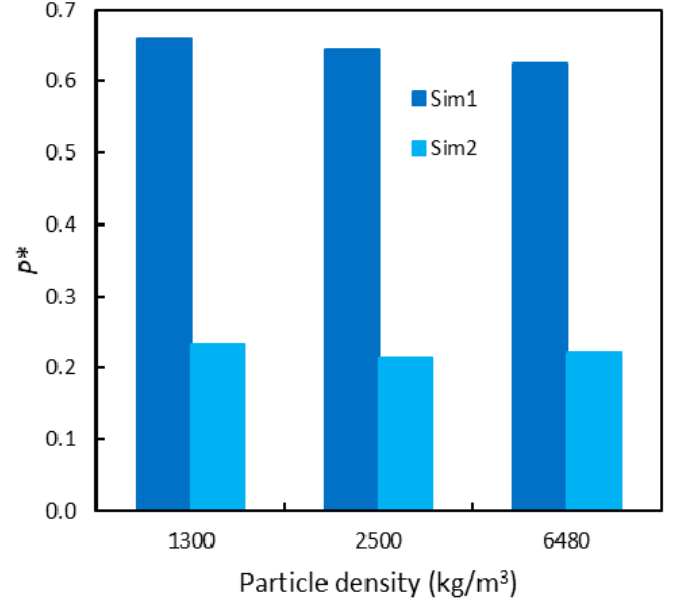
Figure 14. Pressure at the bottom upon varying the particle density.